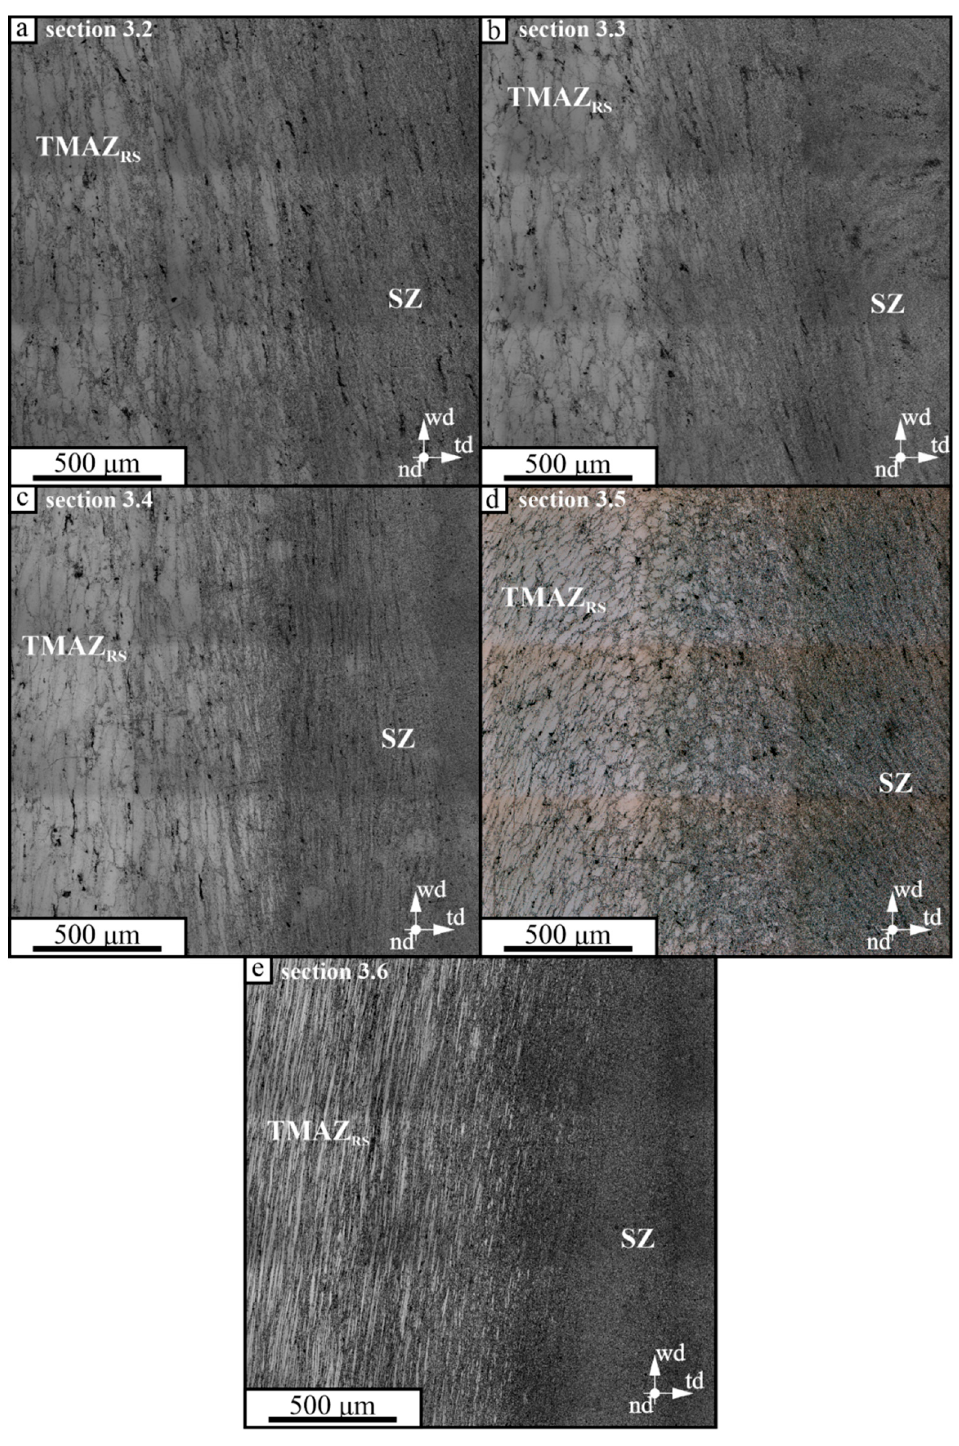
Figure 7. The TMAZ grain structures in planar sections 3.2 ( a ), 3.3 ( b ), 3.4 ( c ), 3.5 ( d ) and 3.6 ( e ), as viewed normal to the sheet plane.